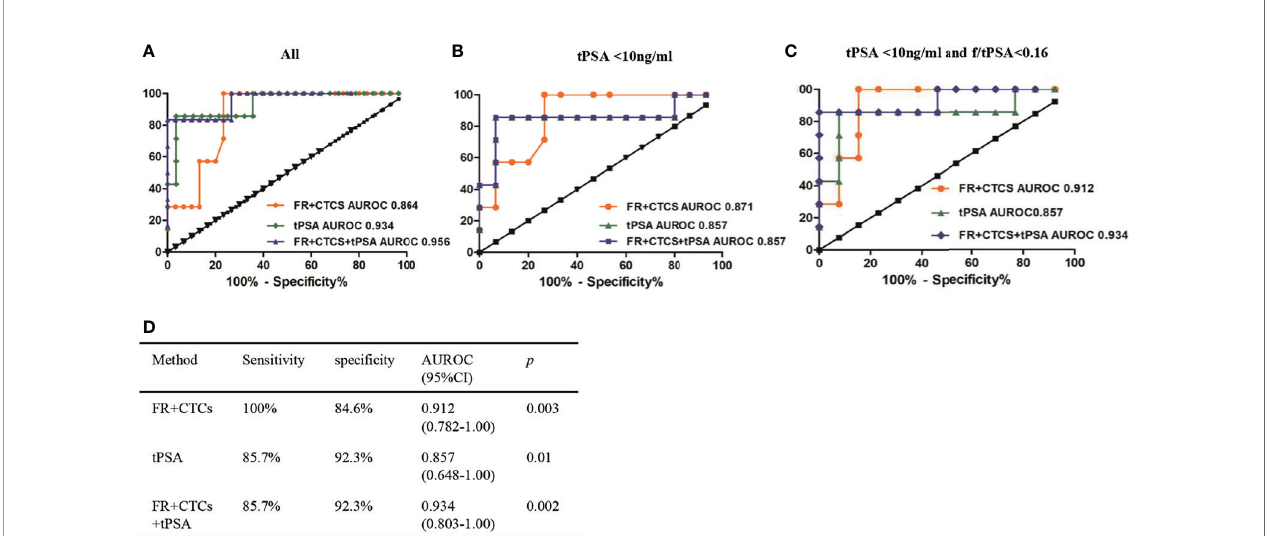
FIGURE 3 | ROC curve of FR+CTCs, tPSA, and the combination for the prostate cancer. (A) ROC curve of FR+CTCs and tPSA in all prostate cancer. (B) ROC curve of FR+CTCs, tPSA, and their combination in the prostate cancer with tPSA <10 ng/ml. (C) ROC curve of FR+CTCs, tPSA, and their combination in the prostate cancer with tPSA <10 ng/ml and f/tPSA <0.16. (D) The diagnostic ef fi ciencies of FR+CTCs, tPSA, and the combination in patients with tPSA <10 ng/ml and f/tPSA